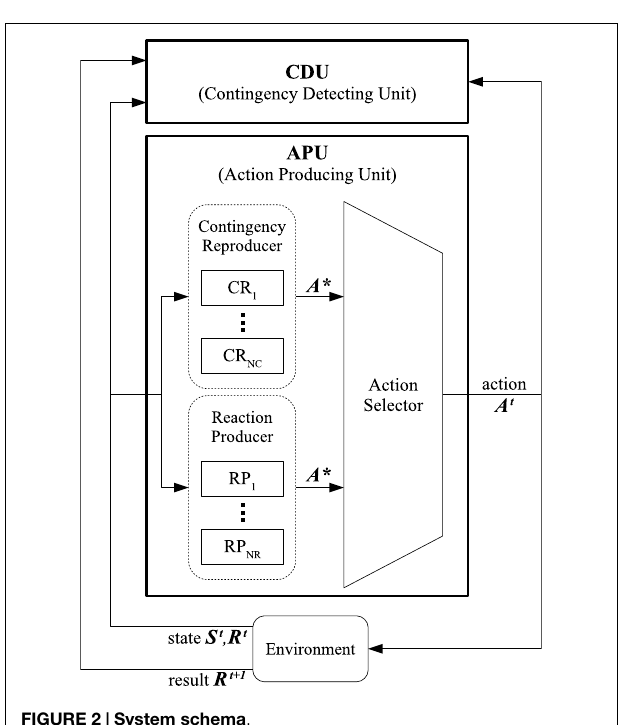
FIGURE 2 | System schema